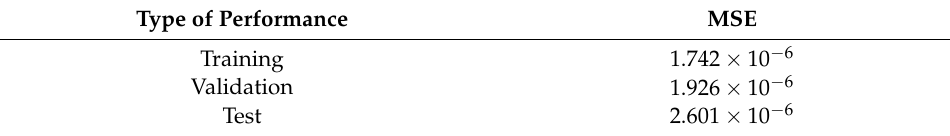
Table 5. Performances for Case B.